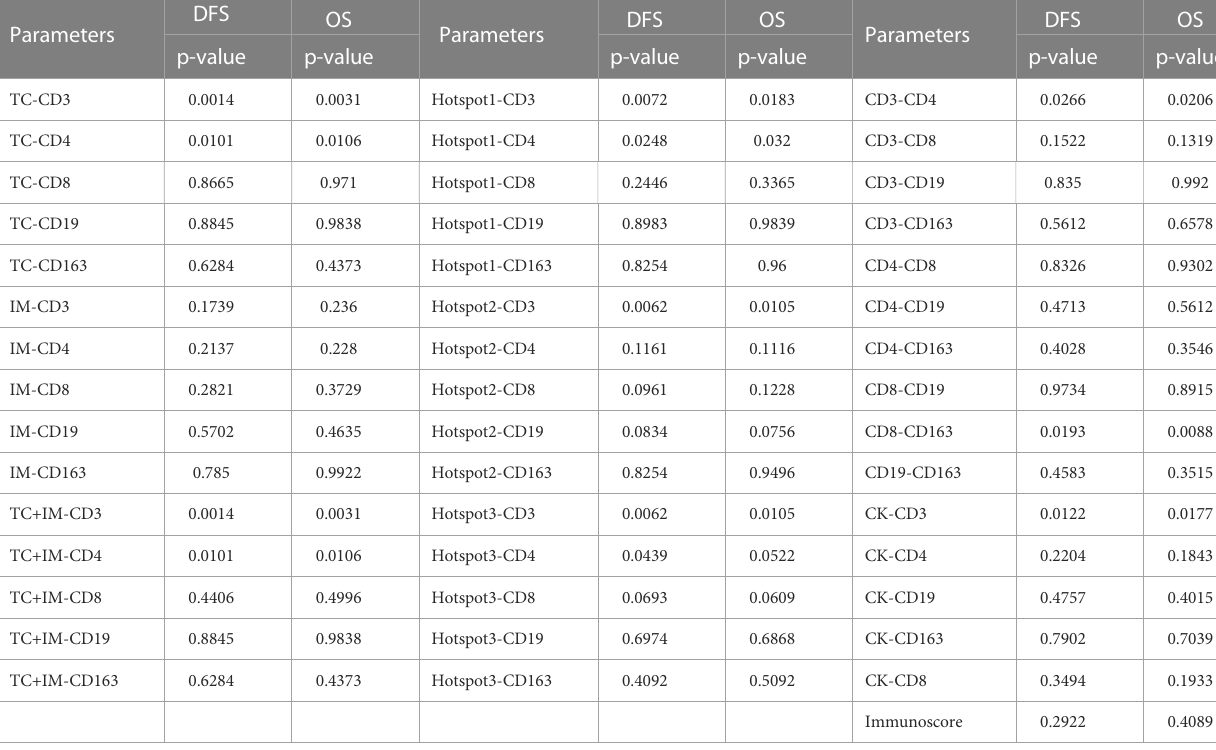
TABLE 3 The univariate survival analysis of all parameters based on cell positive density for the group of all patients.